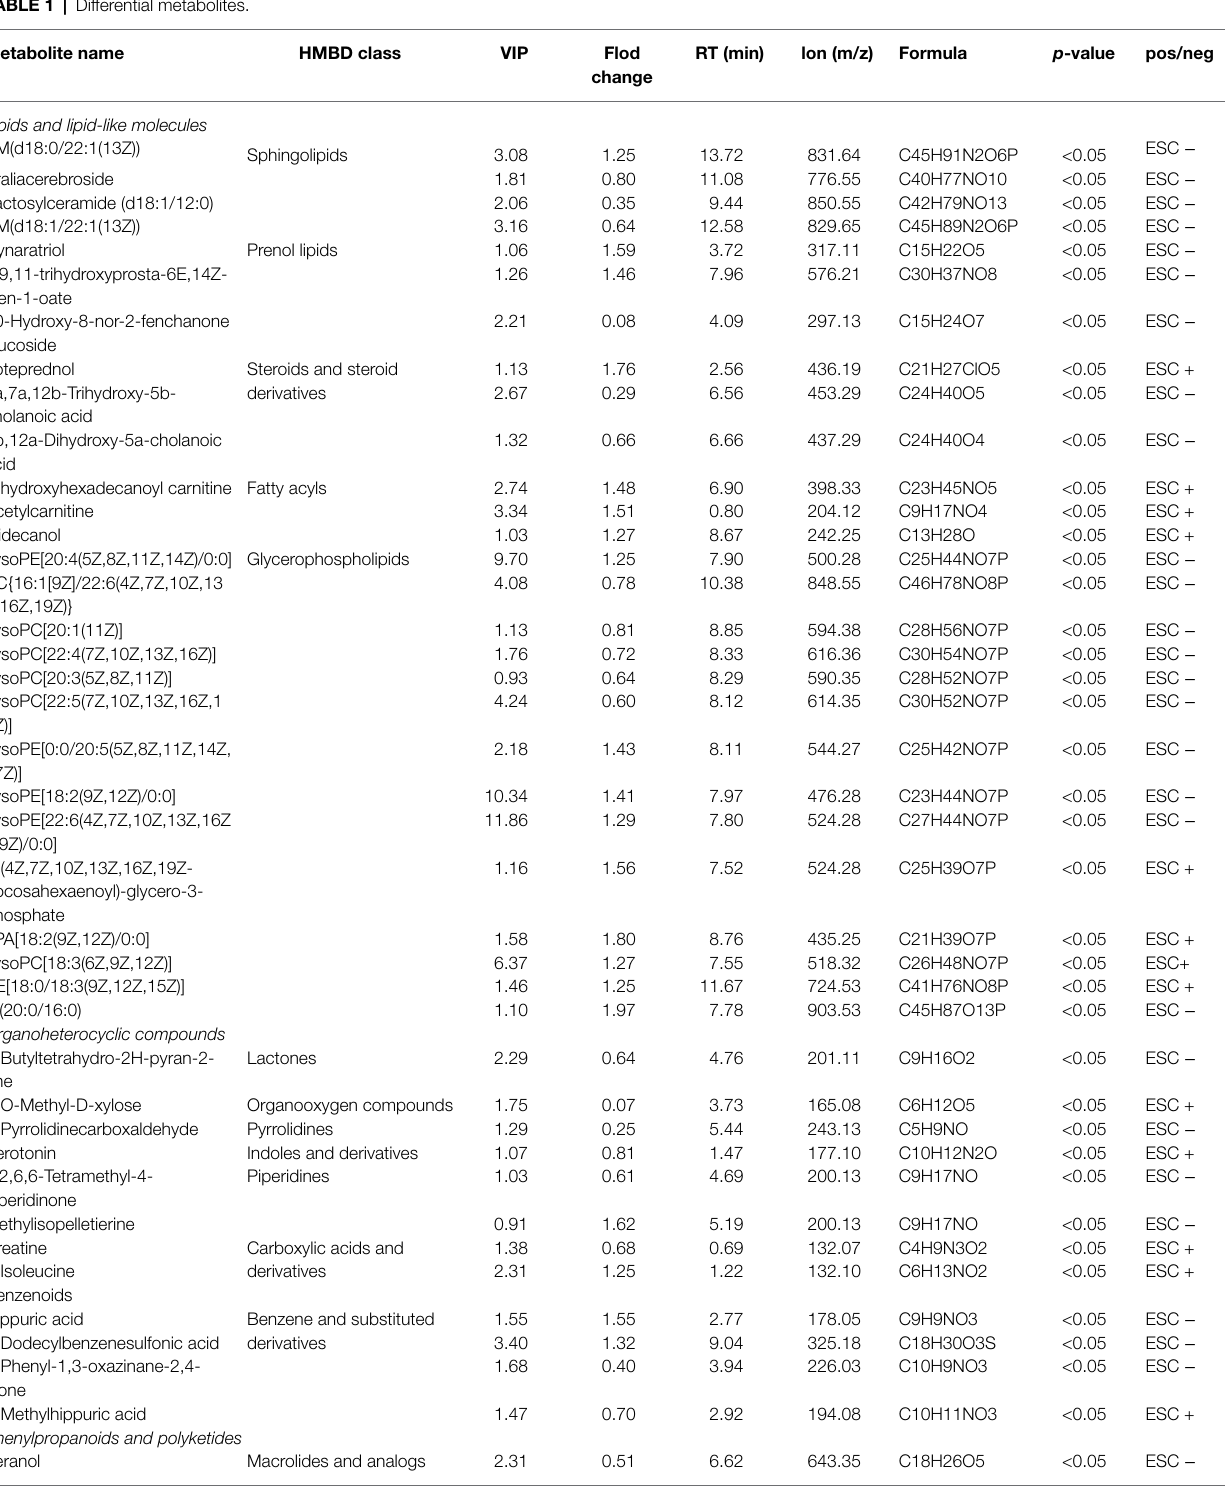
TABLE 1 | Differential